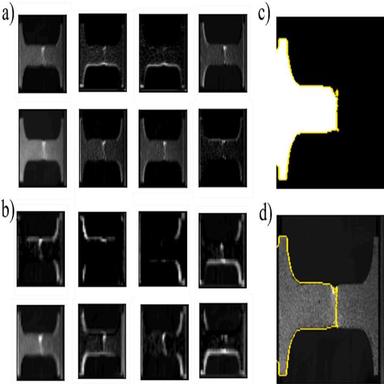
Representative feature maps of the first (a) and second (b) convolutional layer of a high-accuracy UT fracture CNN network. Automated identification results of one of the fractured UT specimen parts characterizing its contour and the crack profile through the combined use of a trained model with the LIME software package are provided in (c), (d).